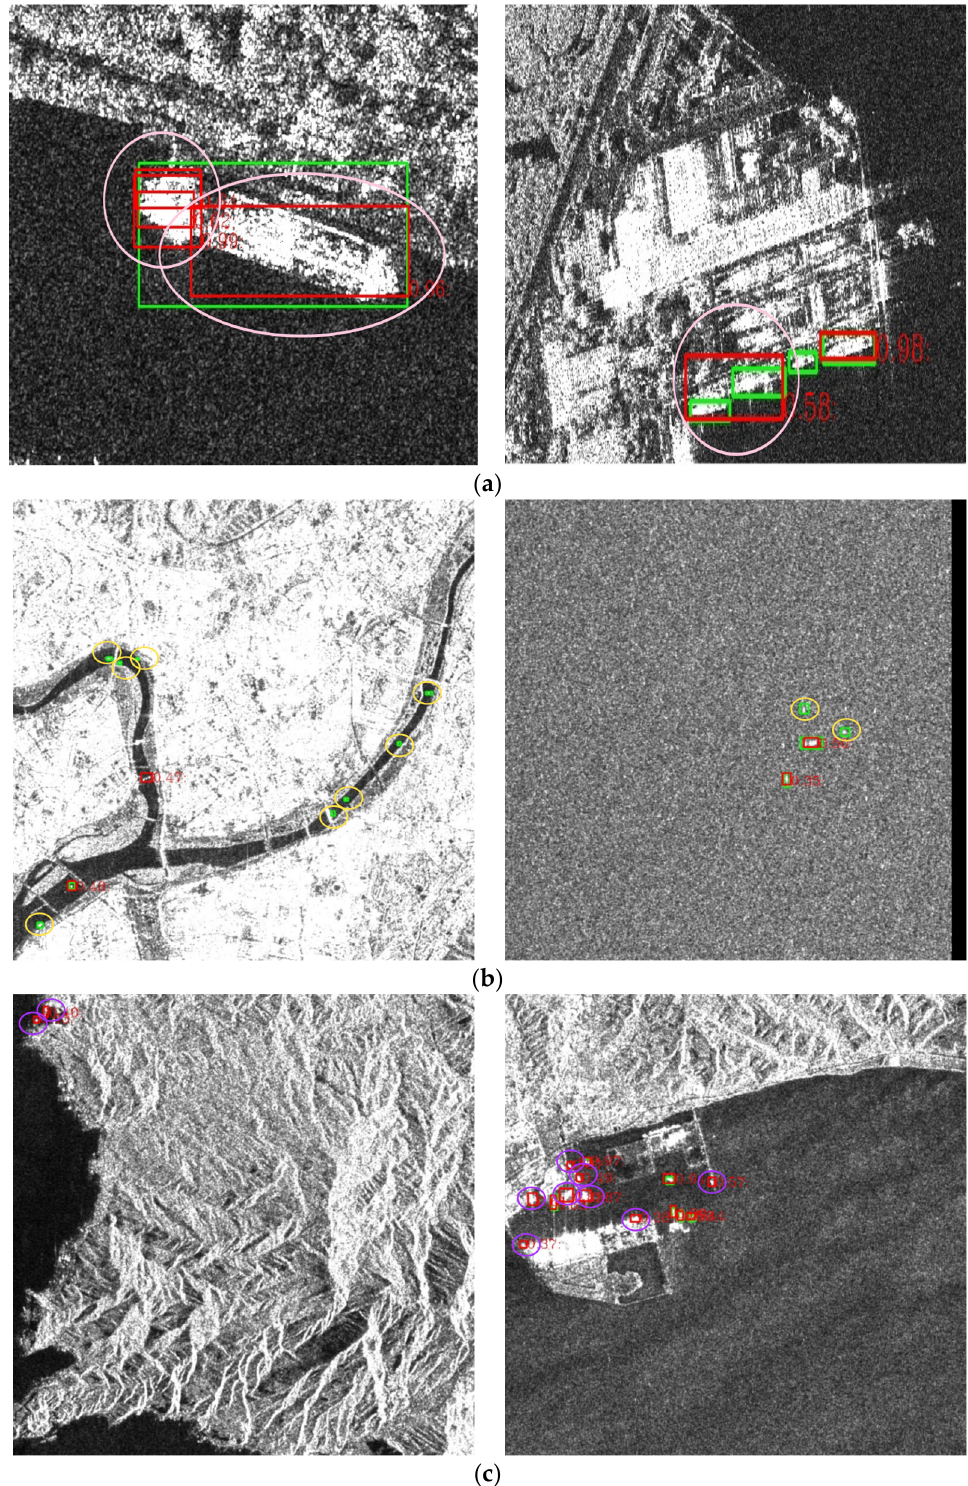
Figure 1. Some detection results of the general detector. ( a ) The problem of inaccurate localization; ( b ) the problem of the missing ships; ( c ) the problem of false detections.